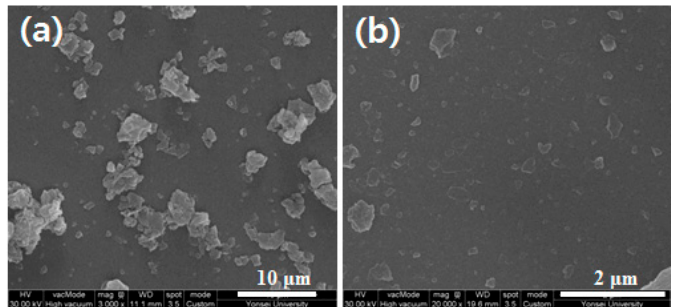
Figure 3. FE-SEM images of PMDA-ODA particles synthesized in water ( a ) before ultrasonication and ( b ) after ultrasonication for 30 min.